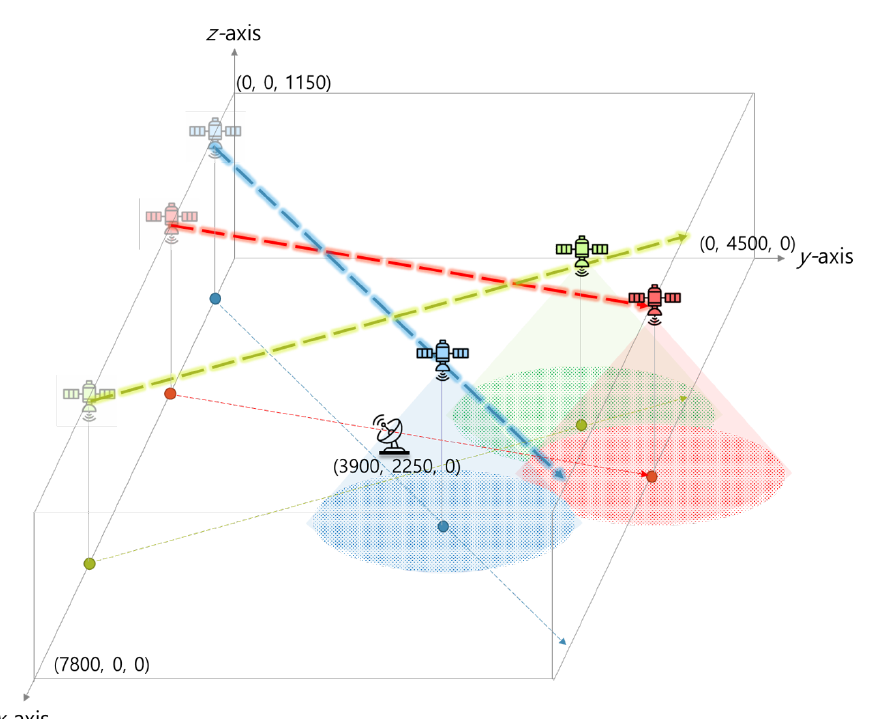
Figure 4. Illustration of a simulation environment.